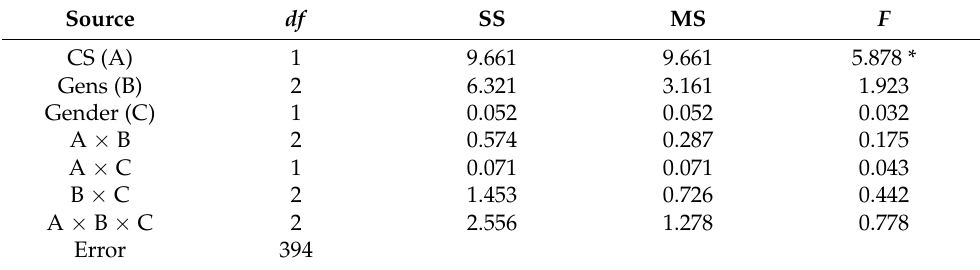
Table 9. Three-way ANOVA for information anxiety (IA).